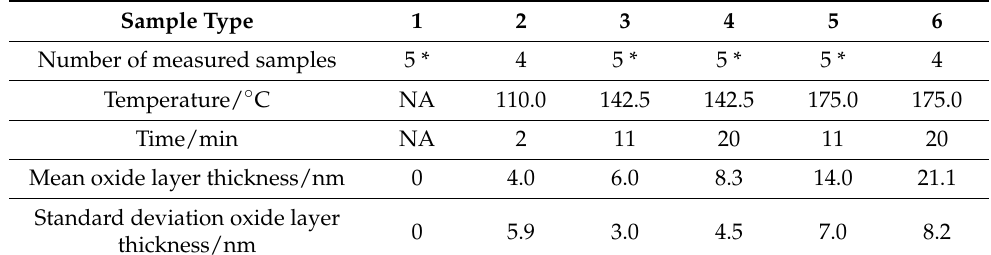
Table 1. Sample preparation protocol for the direct bonded copper substrates.